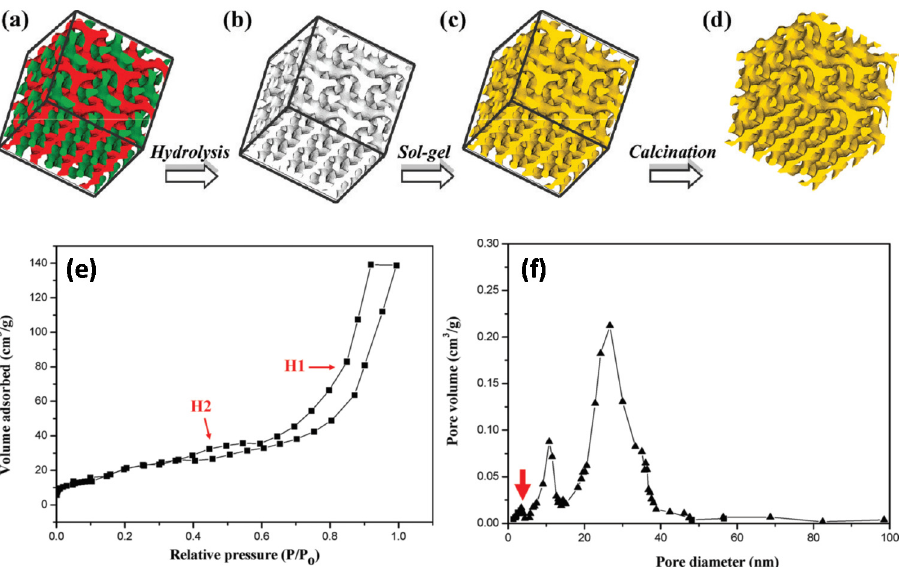
Figure 14. ( a – d ) Schematic illustration for the creation of well-defined, bicontinuous TiO 2 from the templating of BCP: ( a ) PS–PLLA gyroid morphology (skeleton of double gyroid structure with two identical networks (green and red)); ( b ) gyroid-forming, mesoporous PS template after removal of minority PLLA networks. ( c ) PS/TiO 2 gyroid nanohybrids via templated sol-gel reaction; ( d ) bicontinuous TiO 2 with crystalline phase after removal of PS template through calcination. ( e ) N 2 adsorption − desorption isotherm with hysteresis loops, indicating the mesoporous property of the bicontinuous TiO 2 . ( f ) Pore size distribution of the bicontinuous TiO 2 , calculated from the adsorption branch using the BJH method. Two major pore distributions with maxima around 11 and 24 nm pore size can be identified. Adapted from [44].